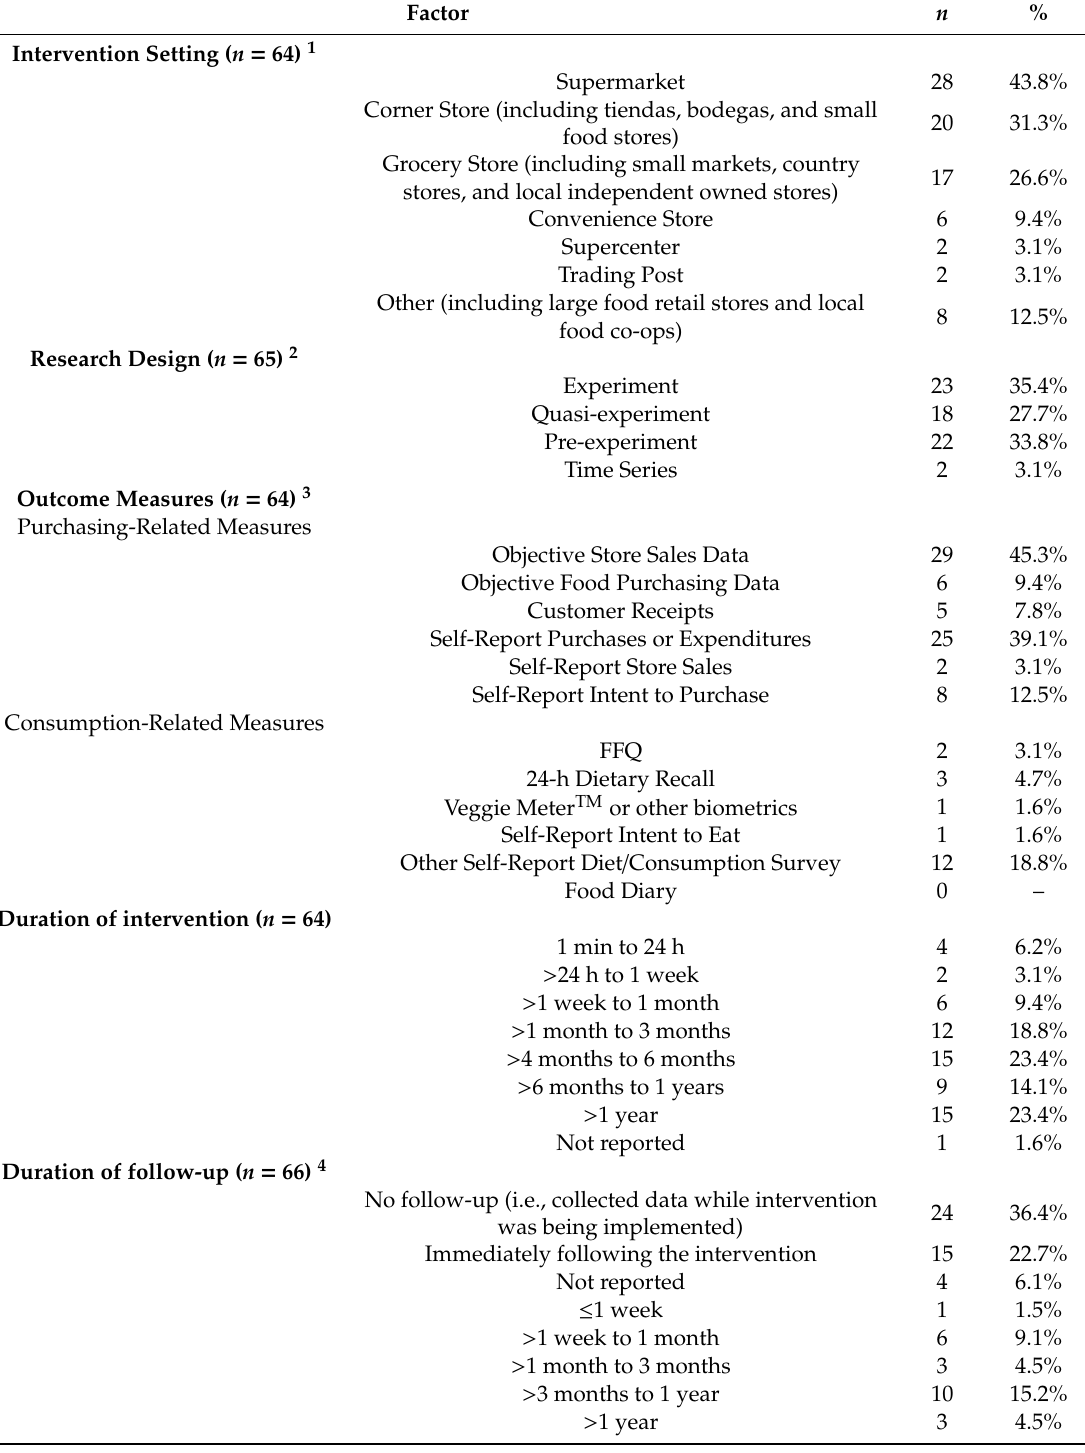
Table 1. Study design characteristics for inclusion